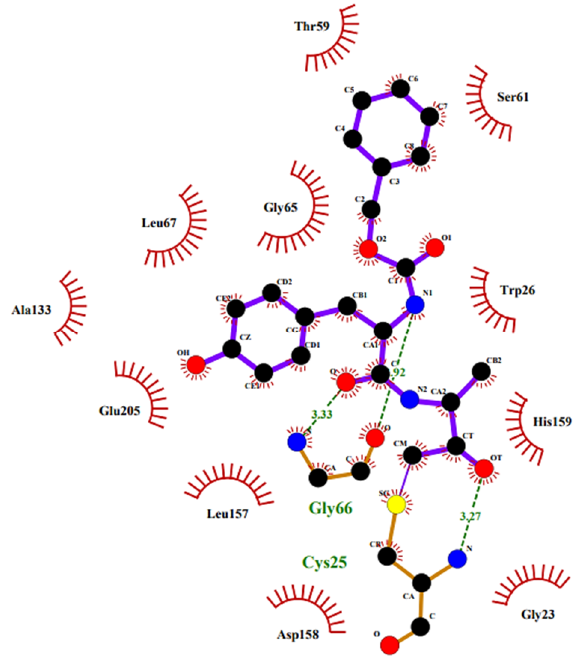
Figure 9. The 2D structure of Z-Tyr-Ala-CH 2 F in complex with cruzain. The 2D plot was generated by LigPlot + (2.1, EMBL-EBI, Wellcome Genome Campus, Hinxton, Cambridgeshire, United Kingdom); hydrogen bonds are shown as green dotted lines, while the spoked arcs represent residues making nonbonded contacts with the ligand.